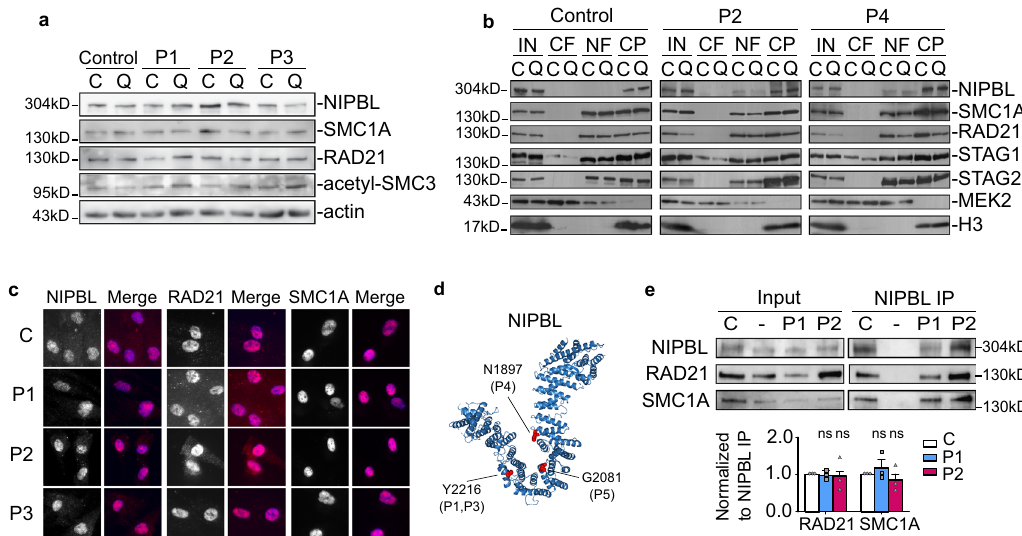
Fig. 1 Cohesin integrity and subcellular localization are not affected in CdLS-derived fi broblasts. a Comparison of protein levels of NIPBL, SMC1A, RAD21, and acetyl-SMC3 in primary fi broblasts derived from a control and three CdLS patients (P1 – 3) under cycling (C) and quiescent (Q) conditions. Actin was used as the loading control. Representative images of one experiment are shown and quanti fi cations of three biological replicates are included in Supplementary Fig. 1a. b The chromatin-bound levels of NIPBL, SMC1A, RAD21, STAG1, and STAG2 proteins in two CdLS patients (P2 and P4) and a control were assessed by chromatin fractionation under cycling (C) and quiescent (Q) conditions. IN, input; CF, cytosolic fraction; NF, nuclear-soluble fraction; CP, chromatin pellet. MEK2 (cytosol) and H3 (nuclear) were used as fractionation controls. Representative blots from one biological triplicate are shown. c Nuclear localization of RAD21, SMC1A, and NIPBL were monitored by immuno fl uorescence of fi broblasts derived from a control and three CdLS patients (P1 – 3). Nuclei were stained using DAPI and merge signal (blue channel + red channel) is shown. Scale bar, 10 μ m. Representative images are depicted and quanti fi cations from more than 3 biologically independent experiments are shown in Supplementary Fig. 2a. d Representation of the mutated residues of NIPBL in the CdLS patient-derived cells under study using Pymol software (Pymol Molecular Graphics System Version 2.0 Schrödinger, LLC) and the Ashyba gossypii Scc2 structure from Chao et al. 69 . Y2216 corresponds to the residue mutated in P1 (Y2216C) and P3 (Y2216S), N1897del in P4, and G2081A in P5 marked as red dots. e Co-immunoprecipitation experiments between NIPBL and cohesin subunits. Similar co-puri fi cation ef fi ciencies were observed in RAD21 and SMC1A upon NIPBL immunopuri fi cation in control and two CdLS patient cells (P1 and P2). Rabbit IgG was used as negative control (marked as − ) for the IP. (Lower panel) Quanti fi cation of relative protein levels of RAD21 and SMC1A normalized to immunoprecipitated-NIPBL. Means and SEMs of three independent biological replicates are shown. Two-sided unpaired student ’ s t -test. Control, white; P1, blue; P2,